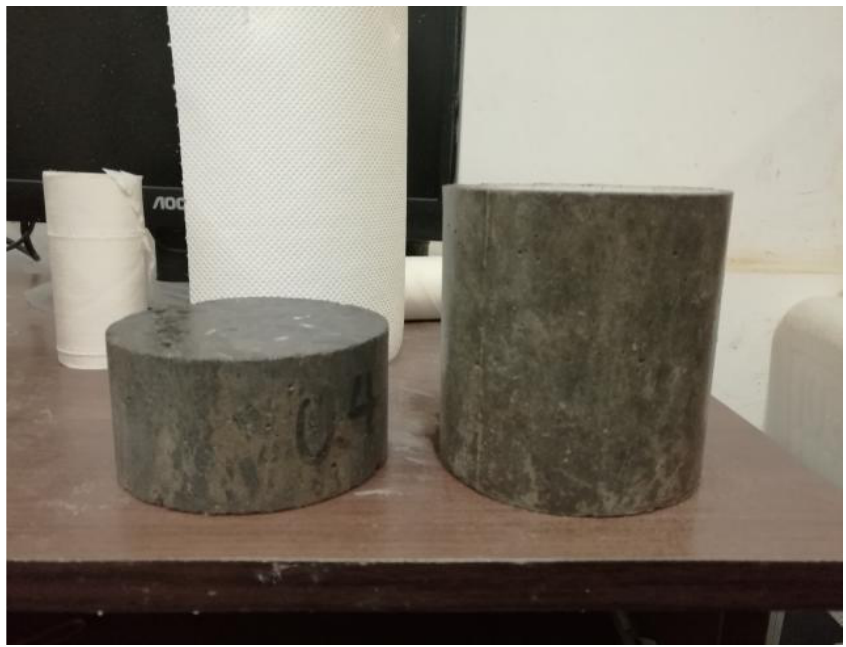
Figure 2. Anti-chloride ion test piece.